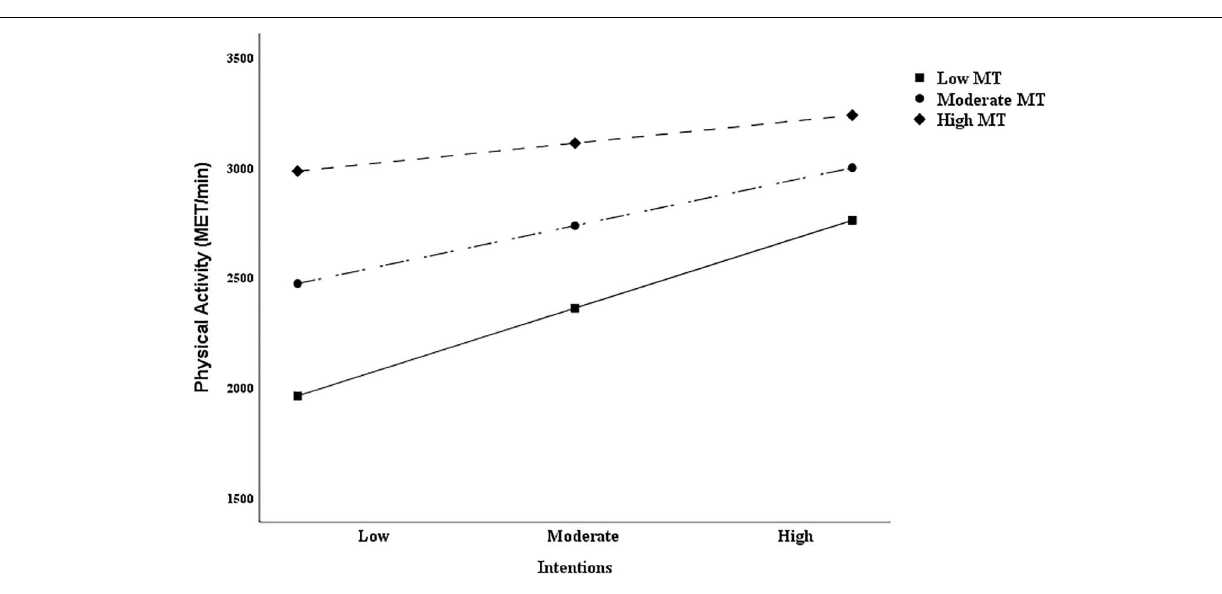
FIGURE 6 | Simple slopes for physical activity intentions and behavior relations at different mental toughness level among wage